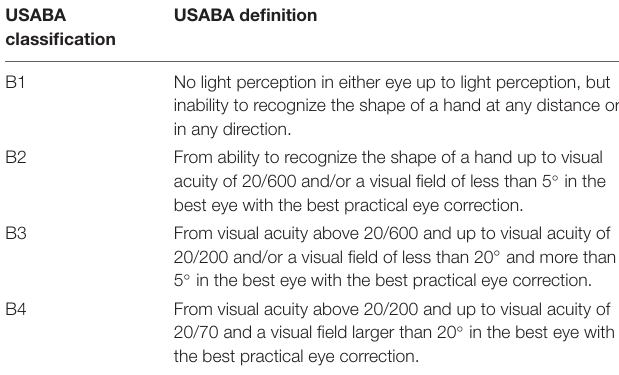
TABLE 1 | USABA classification system